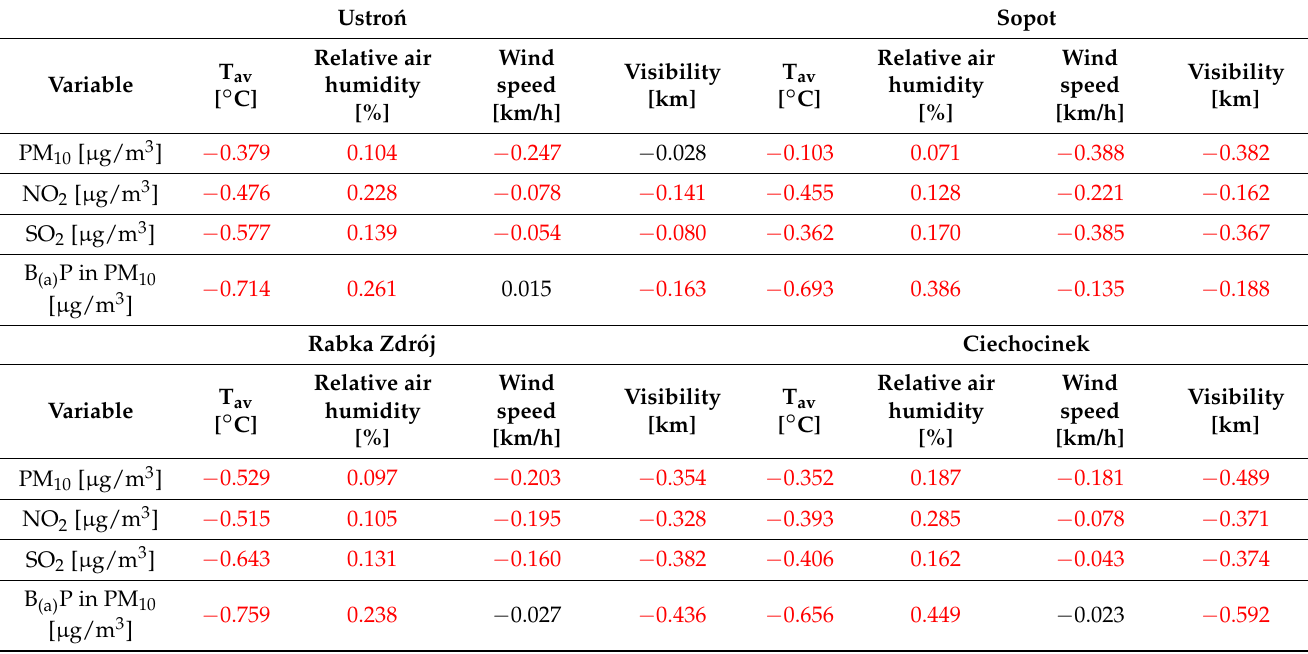
Table 7. Analysis of the linear correlation (Pearson correlation coefficient) between air pollution with selected meteorological parameters and visibility in the health resorts of Ciechocinek, Ustro´n, Rabka Zdr ó j, and Sopot in the years 2015–2019, the red digits indicate the significant correlations at p <